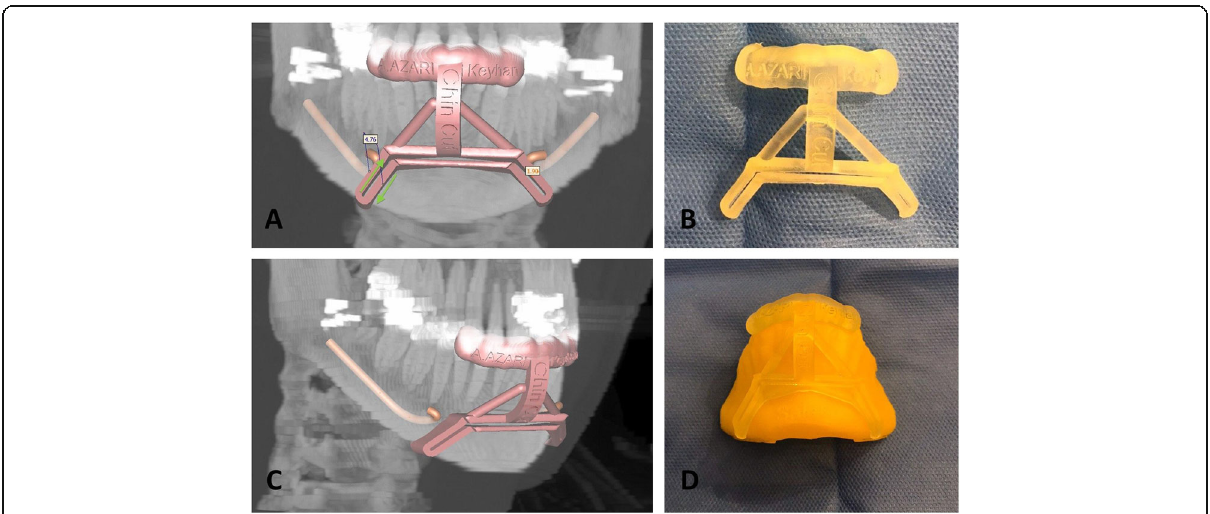
Fig. 2 a , c Digital design of chin osteotomy surgical guide for a sample 24-year-old female patient who underwent computer-assisted horizontal translational osseous genioplasty. b , d For accurate adaptation with the chin anatomy, a clear surgical guide was fabricated using special resin through Rapid Prototyping Technology (SLA technology-RUNA CO., Tehran, Iran)